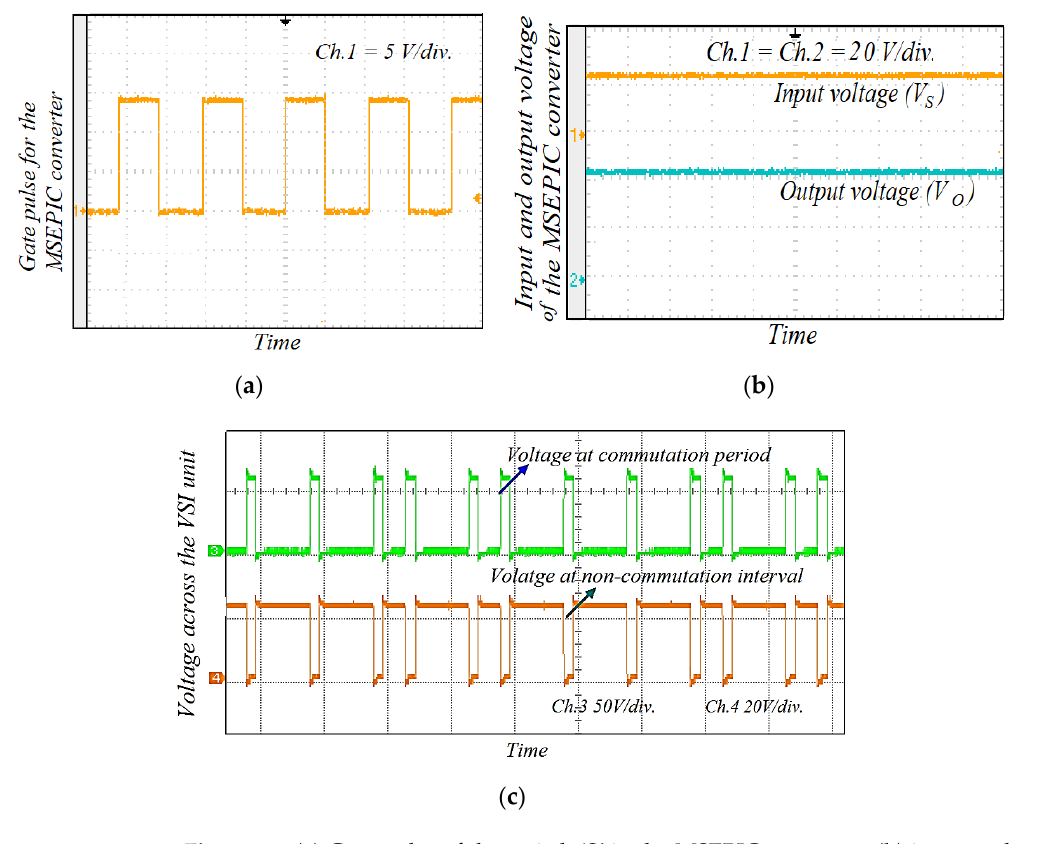
Figure 16. ( a ) Gate pulse of the switch ‘S’ in the MSEPIC converter; ( b ) input and output voltage across the MSEPIC converter; and ( c ) input voltage applied across the VSI of the proposed control strategy.